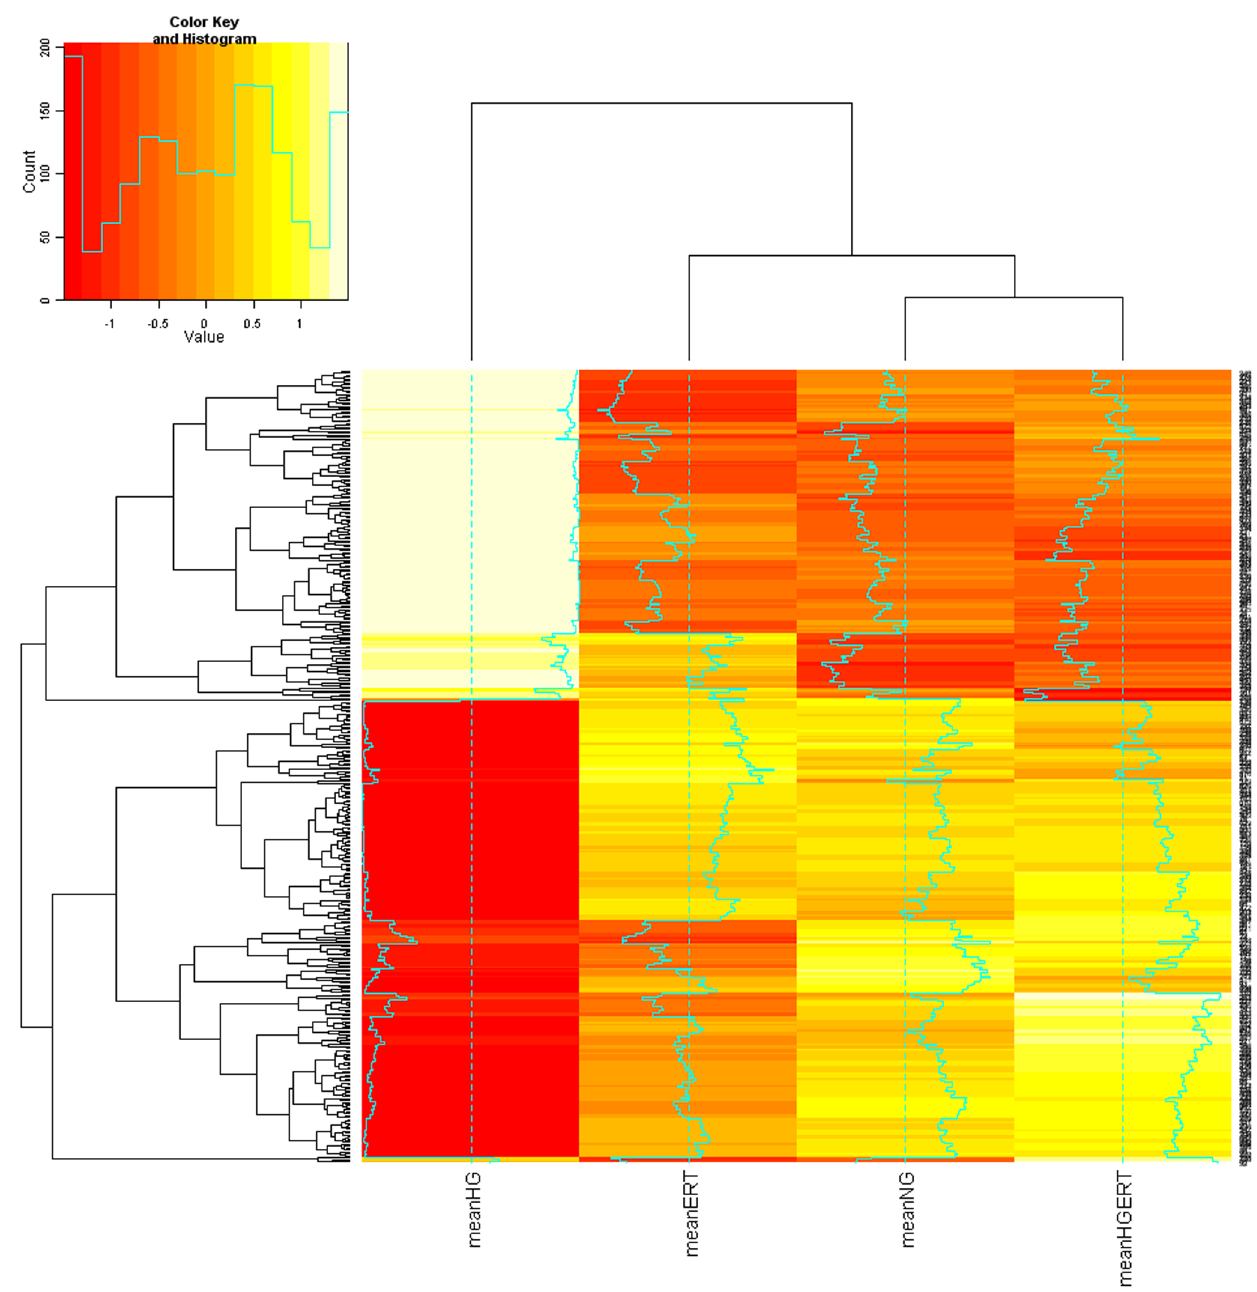
Figure 6. Heat map of transcriptomic analysis. Heat map reflecting the mean gene expression values in the four different treatment groups: From left to right: high glucose (HG, 30 mM), normal glucose and 5 mM erythritol (NGERT), normal glucose (NG), high glucose and 5 mM erythritol (HGERT). Cluster analysis shows that the expression profile in the HG group differs from the other three treatment group that form a separate cluster.